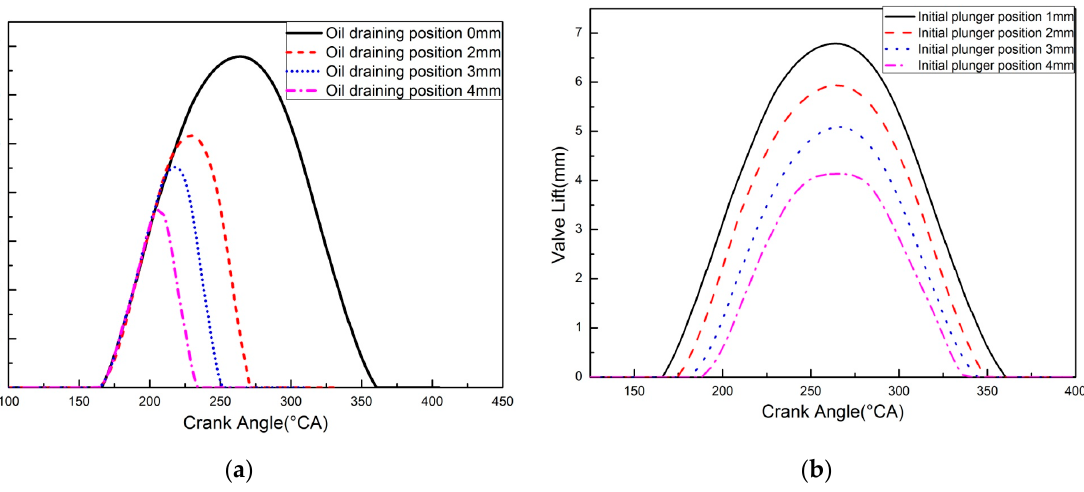
Figure 9. ( a ) Valve lift curve with different times of early releasing oil; ( b ) Valve lift curve with different times of delayed pressuring oil.